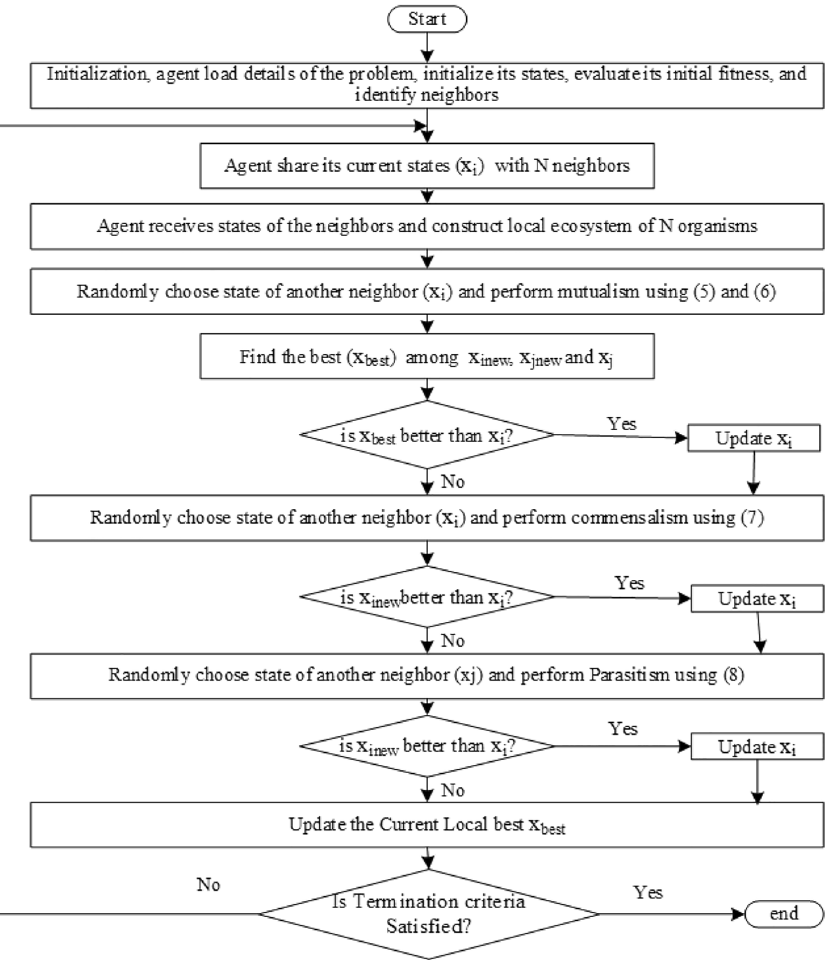
Fig. 2 Flowchart of a proposed multi-agent-based